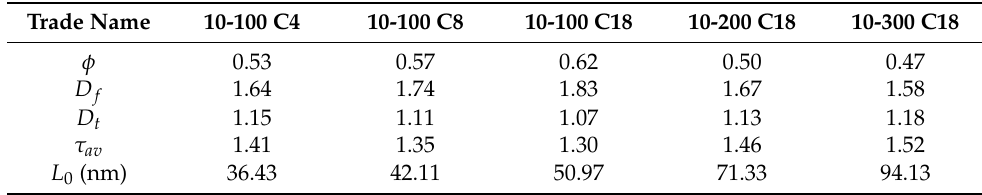
Table 2. The fractal dimensions and related parameters of hydrophobic silica